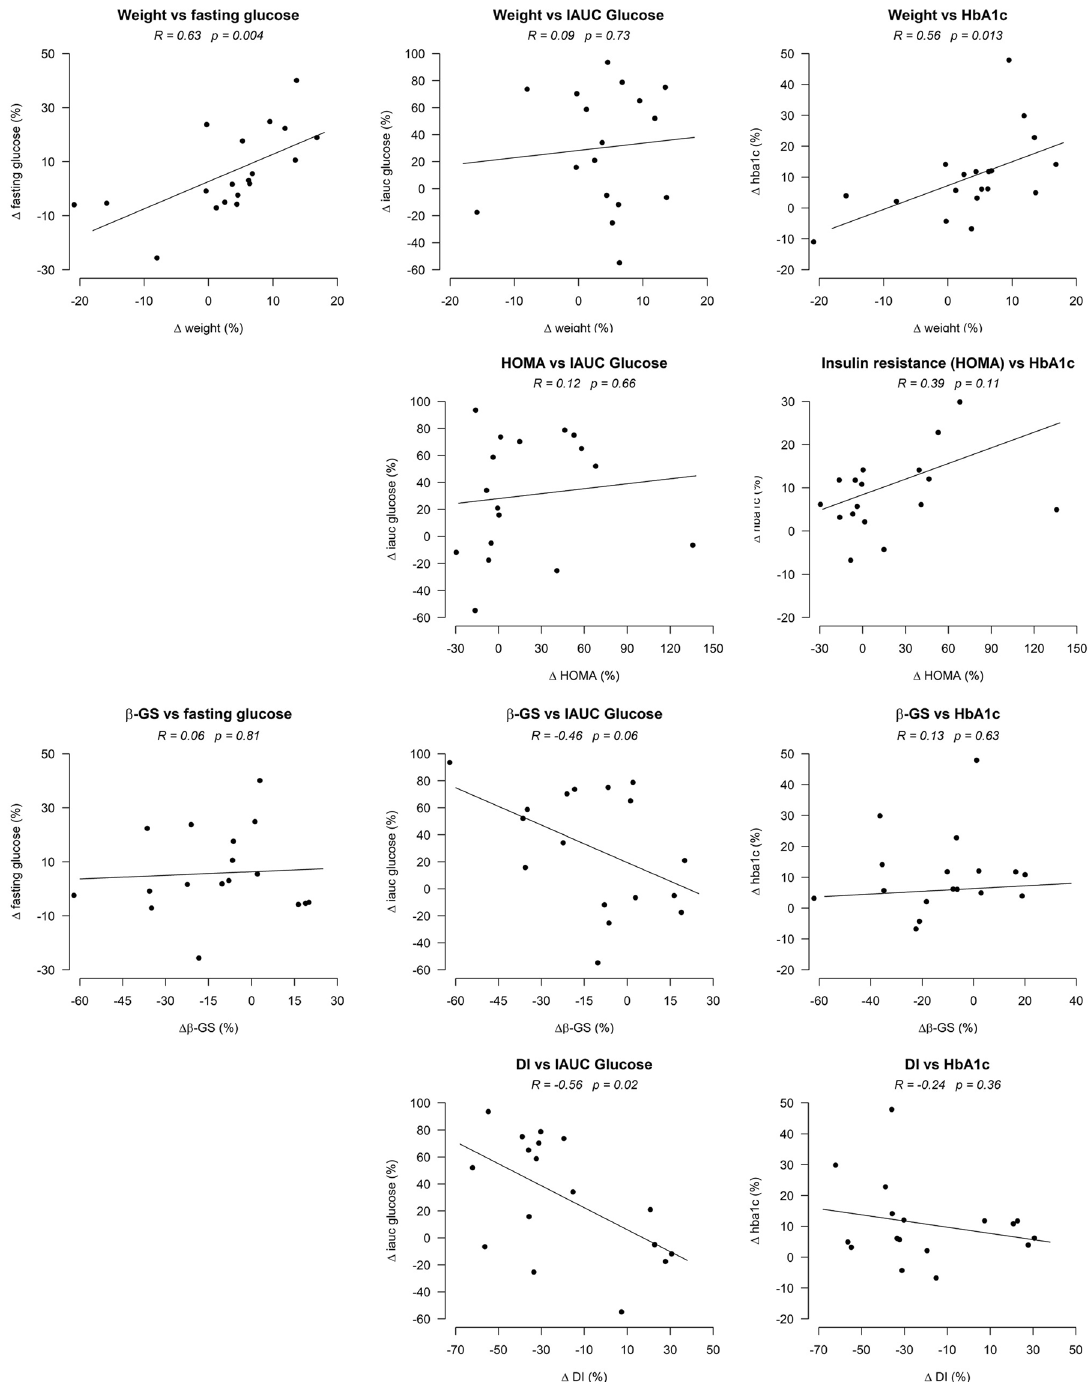
Figure 4. Correlation of relative changes in weight, insulin resistance (HOMA), beta-cell glucose sensitivity (bGS) and disposition index (DI) and changes in fasting and postprandial glucose and HbA1c in patients with type 2 diabetes from 1 y to late after